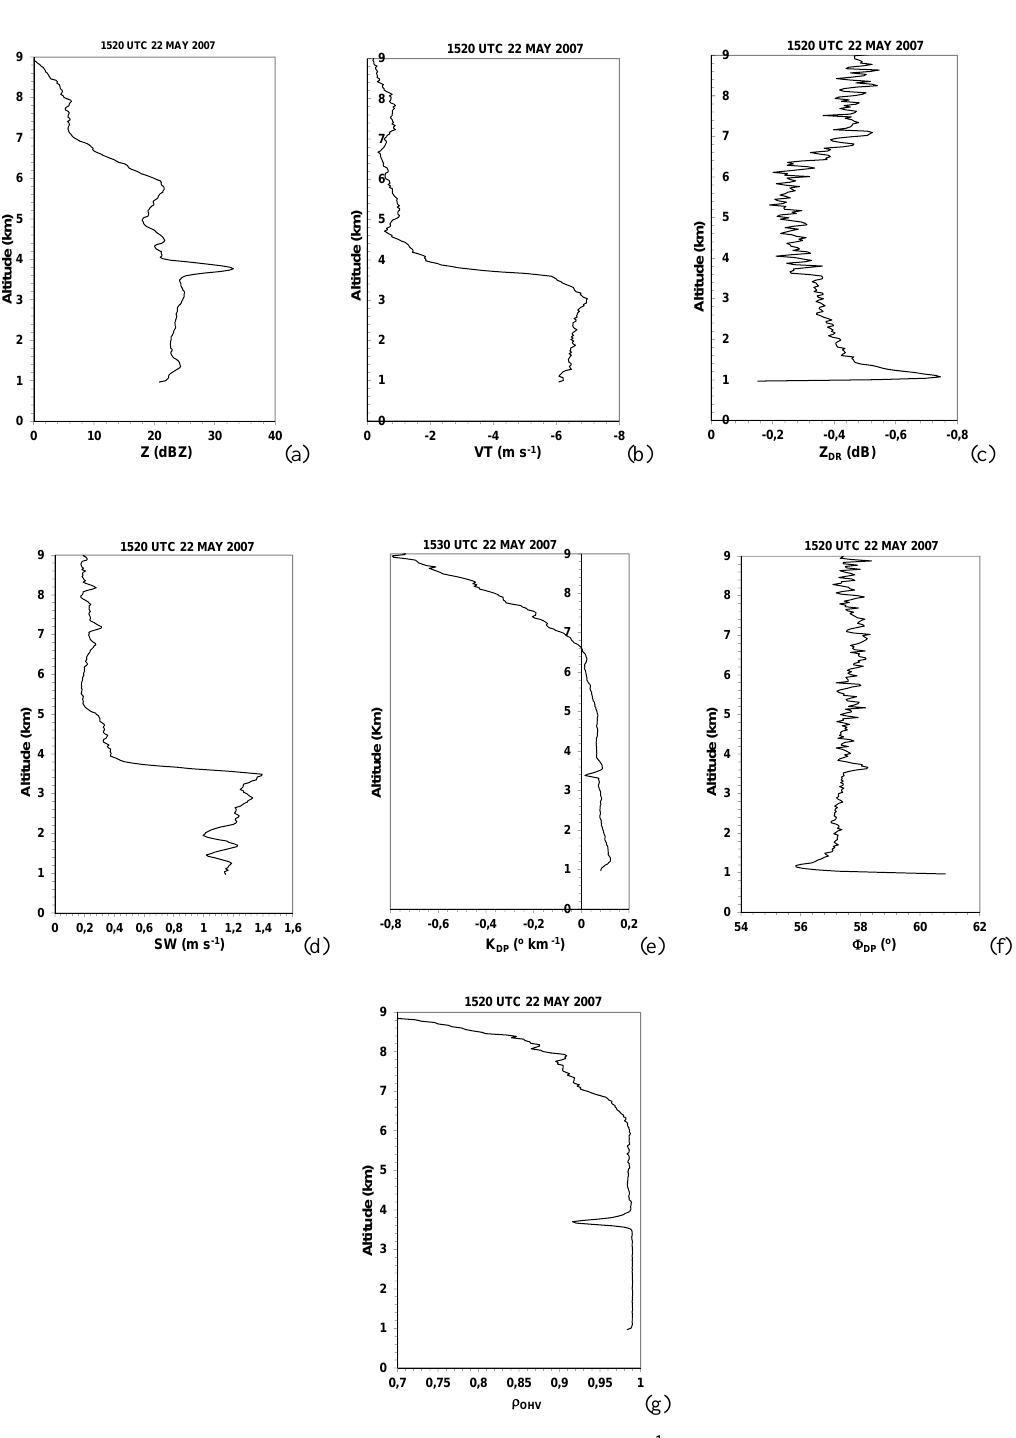
Fig. 5. Vertical profiles of reflectivity – Z h (a) dBZ, radial velocity – V T (b) ms − 1 , differential reflectivity – Z DR (c) spectral width – SW (d) , specific differential phase – K DP (e) degreekm − 1 , differential propagation phase – ϕ DP (f) degree, and correlation coefficient VH – ρ oHV (g) obtained with MXPOL at 15:30UTC on 22 May 2007. Full clockwise antenna scan (6.0 ◦ s − 1 ) at 90 ◦ elevation for pulse width=0.2s, PRF=1000Hz and 256 samples, 1z